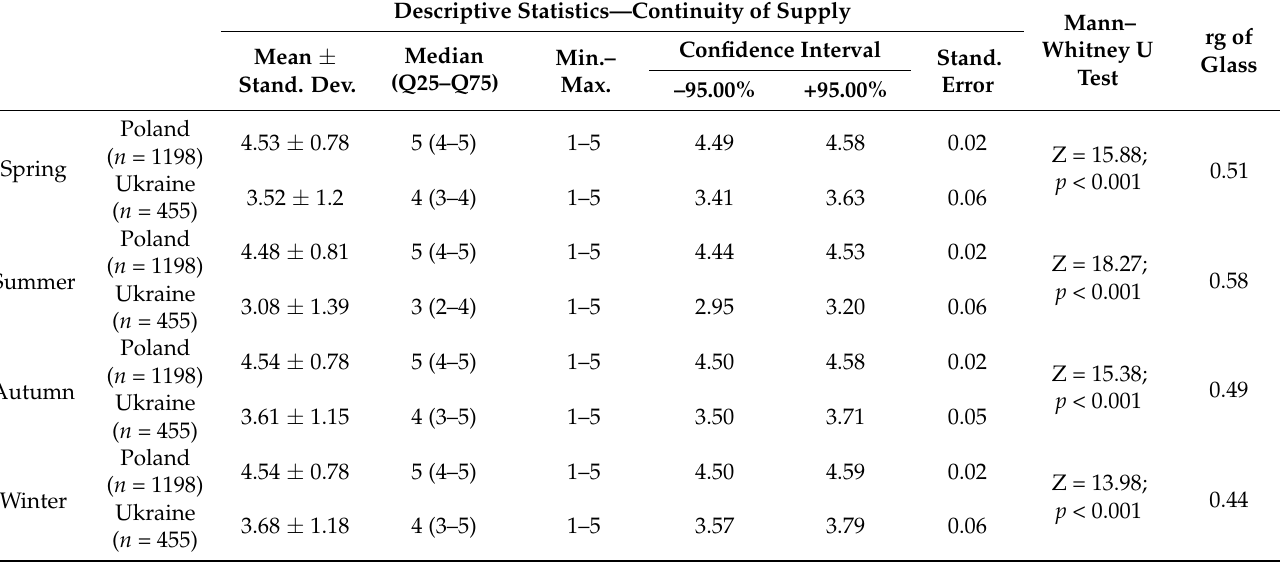
Mann– rg of Whitney U Test